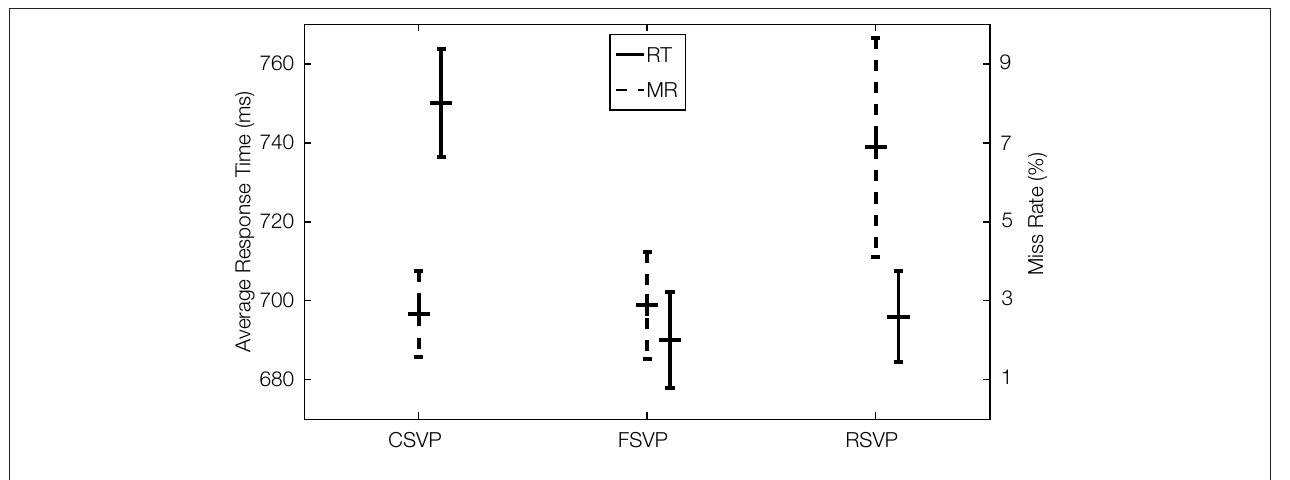
FIGURE 2 | Group results showing miss rates (MRs) and response times (RTs) to targets for the three types of stimuli. The solid lines show the mean RT (labeled on the left Y -axis of the fi gure) to the three types of targets, with the error bars indicating the 95% confi dence interval of the mean RT (the standard